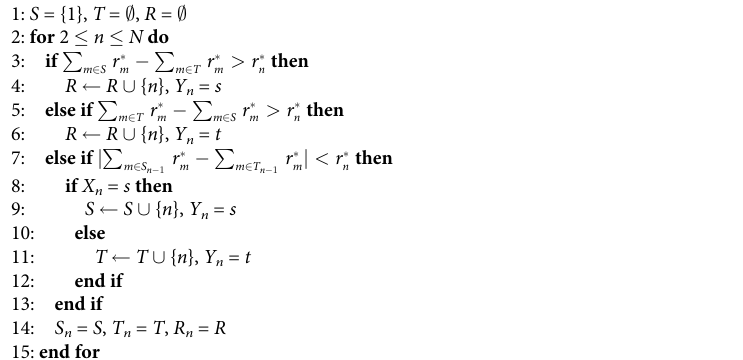
Table 1. Algorithm for optimal decision determination in sequential decision-making. See text for the definitions of subsets S , T , and R , the log-odds ratio of the n -th respondent’s ability, r � an empty